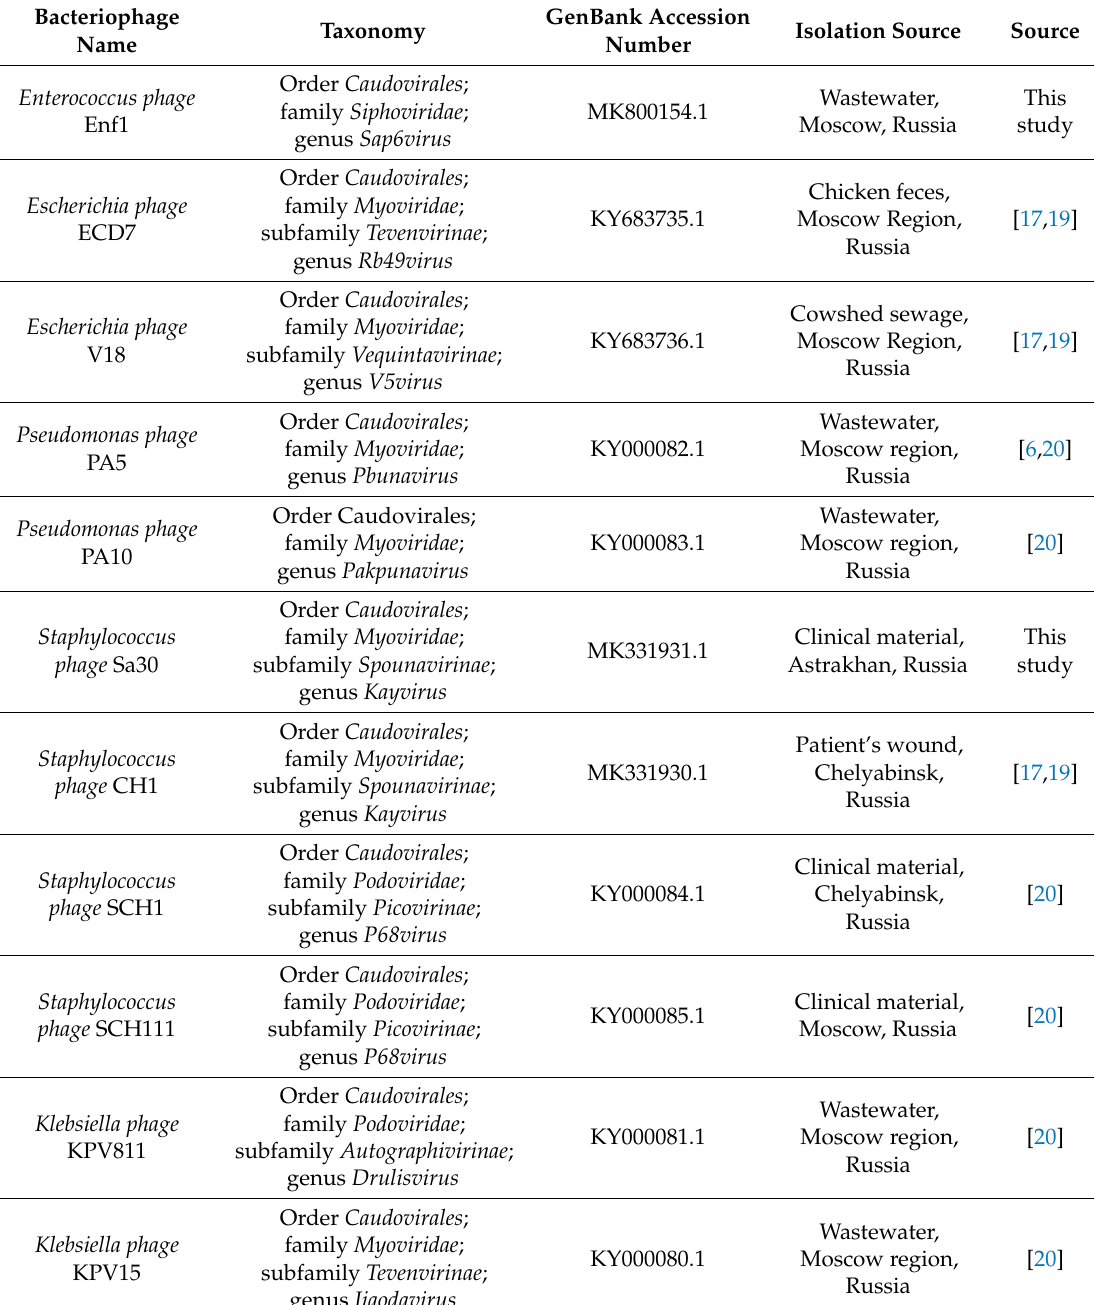
Table 2. List of bacteriophage